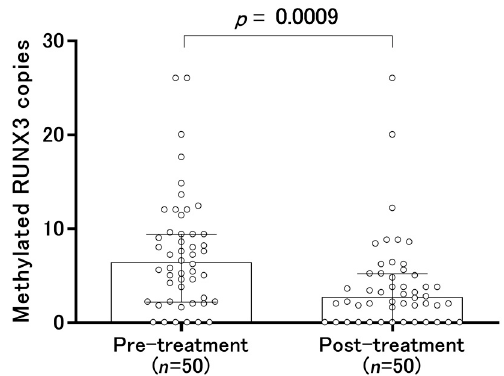
Figure 4. Changes in serum-methylated RUNX3 copies before and after treatment. In the panel, box plots show the median and interquartile range (25th and 75th percentiles).